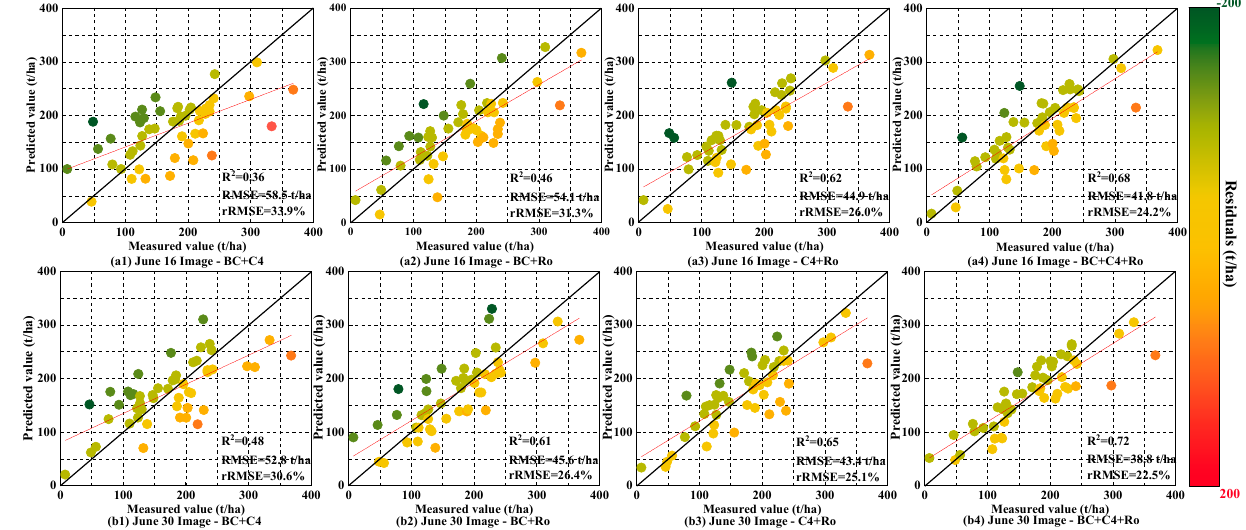
Figure 11. Scatterplots between predicted and ground-measured AGB using combined feature sets. It was found that the ranges of errors were decreased after using combined feature sets, and the number of samples with over-estimated or under-estimated results was obviously reduced, especially for the mapped forest AGB by BC + C4 + Ro in two images (Figure 11(a4,b4)). Figure 11 also illustrates that the saturation levels were alleviated to a large extent after using combined feature sets. It is inferred that different types of features extracted from quad-polarimetric SAR images have a better compensation effect and the accuracy of mapped forest AGB is significantly improved. Ultimately, the maps of forest AGB in two images were generated using MLR and combined feature sets (BC + C4 + Ro), and the results of mapped forest AGB are shown in Figure 12. The results showed that mapped forest AGB ranged from 0 to 384.8 t/ha for images acquired on 16 June, and from 0 to 371.2 for images acquired on 30 June, respectively.